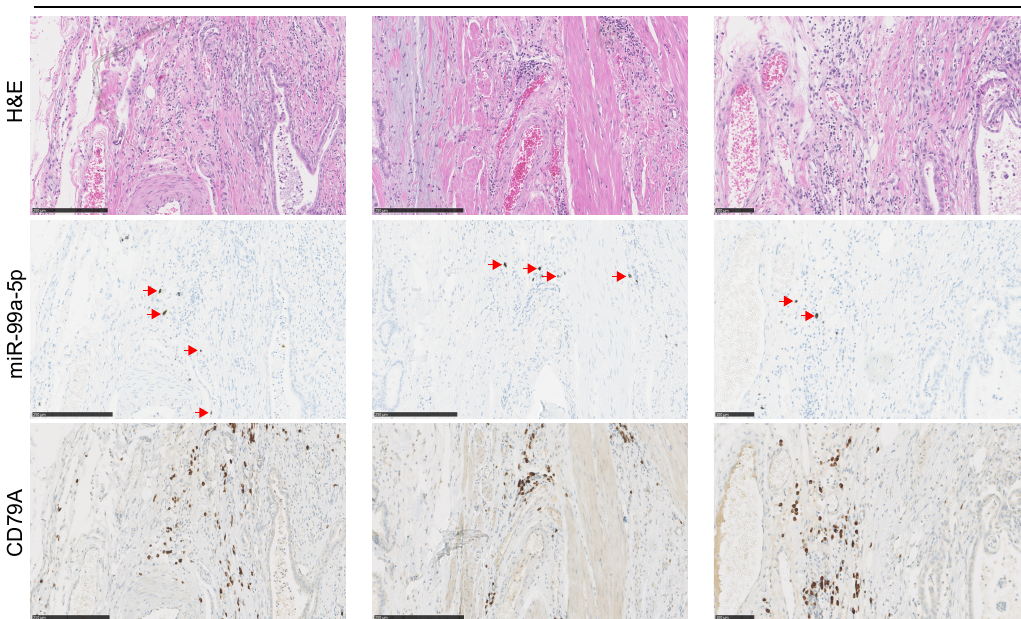
Figure 4. MiR-99a-5p detection by in situ hybridization in pancreatic cancer tissues. Serial FFPE tissue sections were stained with H&E a DIG labeled miR-99a-5p probe, or the B-lymphocyte lineage marker CD79A antibody by immunohistochemistry (brown). Red arrows indicate miR-99a-5p expression, detected with silver staining resulting in brown / black coloring, whereas cell nuclei are stained with hematoxylin in blue. Scale bars are 250 µ m in the first two columns; scale bar is 100 µ m in the right-most